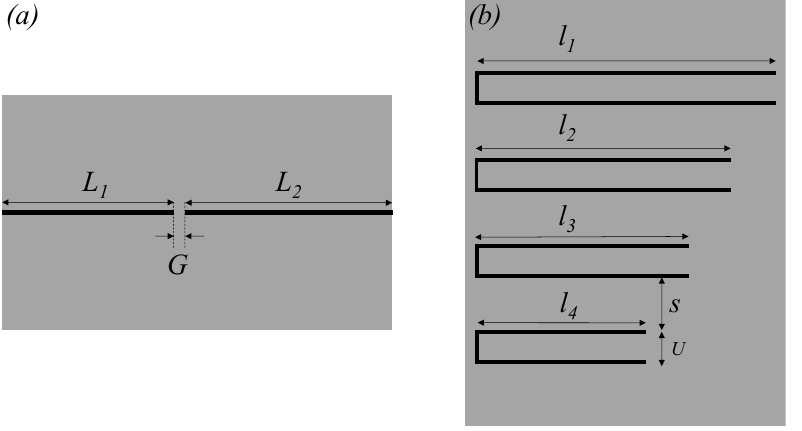
Figure 7. Topology of the ( a ) reader (sensitive part) and ( b ) 8-bit (or 4-resonator) encoder. For each harmonic signal, tag displacement on top of the reader generates an amplitude-modulated (AM) signal. The amplitude of the envelope function should be negligible unless a C-shaped resonator tuned (second resonance) to the frequency of that harmonic signal